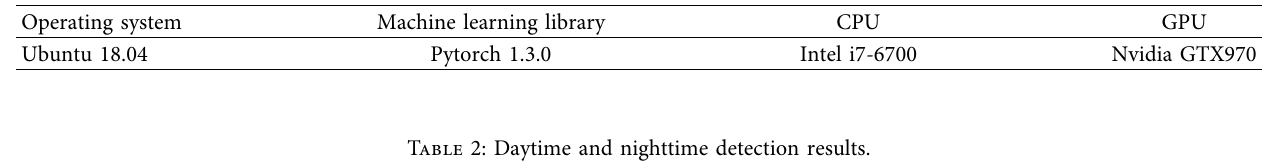
Table 1: Equipment used for the DG vehicle detection test.